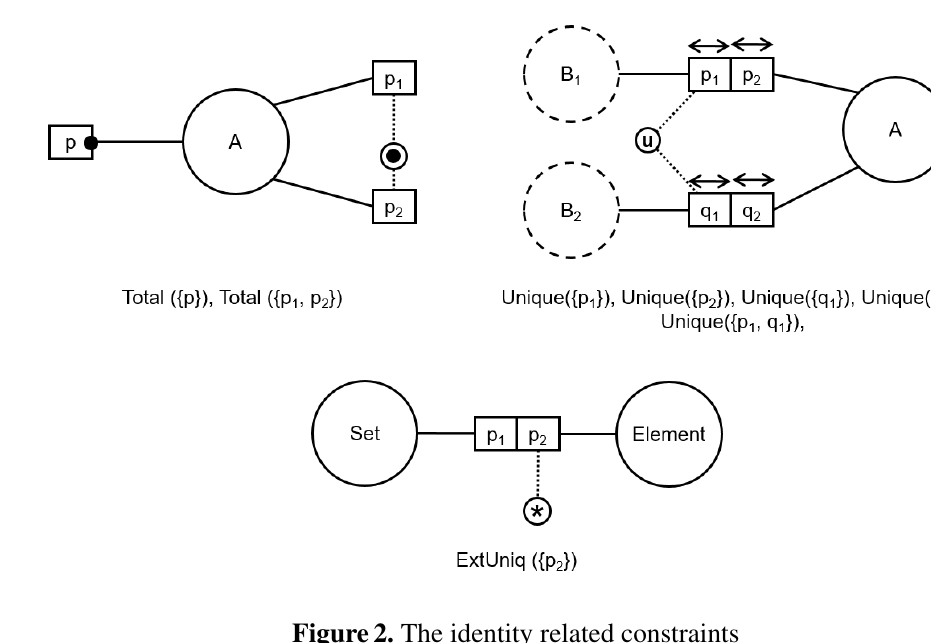
Figure 2. The identity related constraints